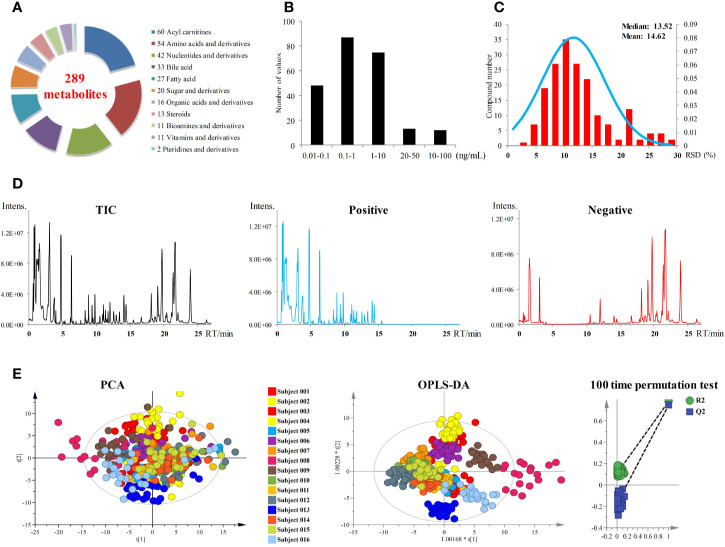
(A) Metabolites coverage of the targeted metabolomics method. (B) LOQs of the metabolomics method. (C) Performance of pooled plasma QC samples during sequence analysis. (D) Total ion currents (TICs) of plasma samples. (E) PCA and OPLS-DA score plots of 393 plasma samples from 16 subjects. OPLS-DA model was validated by random permutation test with 100 iterations. No overfitting was observed.